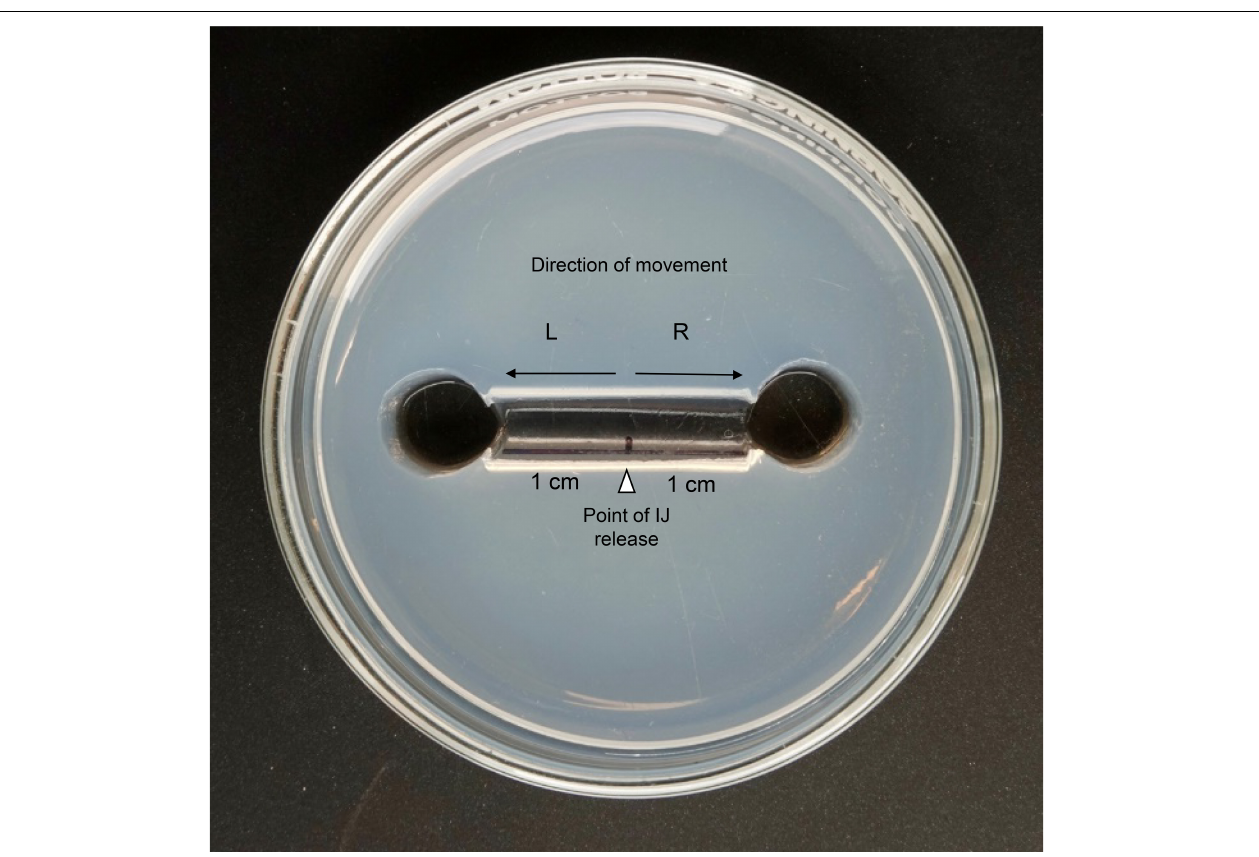
FIGURE 1 | Agar plate arena following. Two wells are connected by a central canal and filled with 3 ml of deionized water (DI) to balance the moisture of plates through the experiment. After 15 min, 2 ml of DI water was removed from plates, leaving a thin layer of water into the canal. The remaining thin layer of DI is necessary to keep infective juveniles (IJs) in the canal throughout the experiment and to diffuse cues. The flat level surface was verified by a bubble level cell phone application. A single infective juvenile (IJ) was released into the middle of the central channel in the assay arena. After 10 min, the direction of movement of each IJ was recorded as right (R) or left (L) based on the movement of the IJ from the release point. Any IJ movement away from the point of introduction was considered as directional migration.